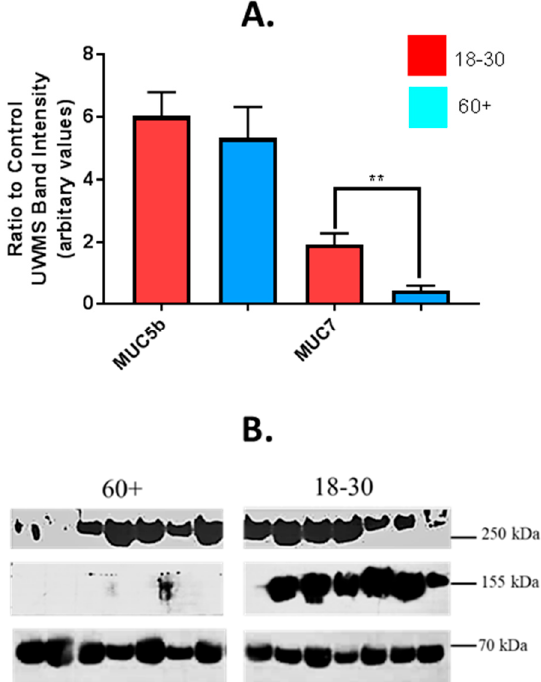
Figure 2. MUC5b and MUC7 in UWS of older and younger adults determined by immuno-blotting ( A ) Mean ( +/ − SEM) MUC5b and MUC7 expression in UWS from older ( n = 24) and younger ( n = 30) subjects, determined by immuno-blotting. Band intensity expressed as a ratio to band intensity of control UWS sample. Difference in means between groups tested for statistical significance using student’s t test. p = < 0.05 * p = < 0.01 ** p = < 0.001 ***. ( B ) Representative image of an SDS-PAGE gel PAS of UWS from older (60 + years) and younger (18–30 years) adults stained for mucin glycoproteins. Approximate molecular weights: MUC5b 250 kDa, MUC7 155 kDa, amylase (used as loading control) 55 kDa.